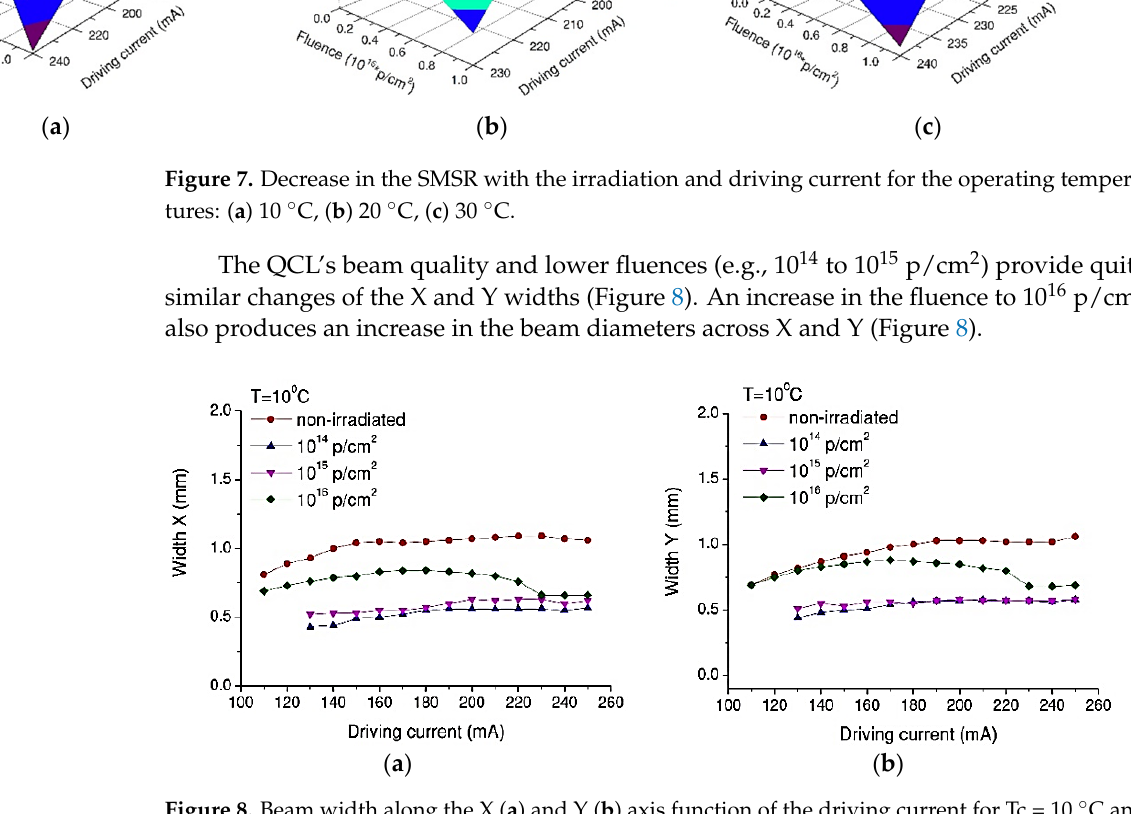
Figure 8. Beam width along the X ( a ) and Y ( b ) axis function of the driving current for Tc = 10 °C and different fluences.